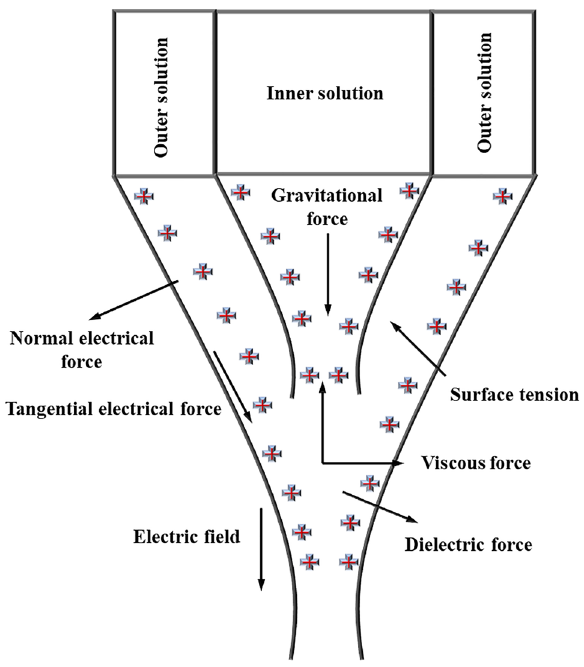
Figure 1. Forces acting around needle tip during CE-Jet printing